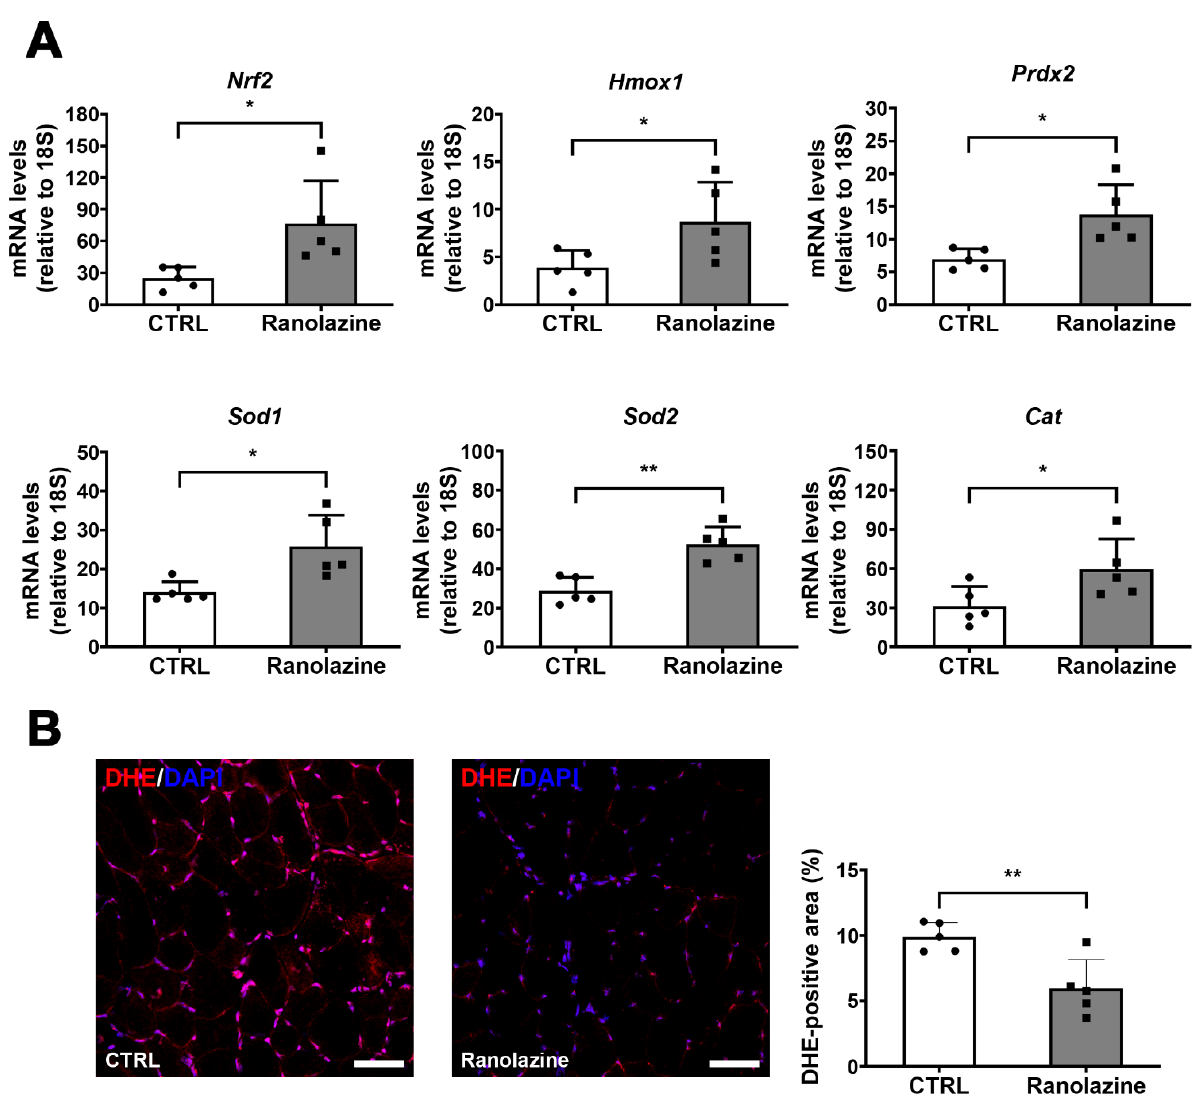
Figure 5. Up-regulation of antioxidant genes and decreased ROS in skeletal muscle upon Ranolazine treatment. ( A ) qPCR expression analysis of key genes involved in oxidative stress response on whole TA muscle lysates derived from old mice treated with Ranolazine or not (CTRL). Data are reported as relative to the housekeeping gene 18S. ( B ) Representative images of 8 µm-thick TA cryosections of old mice treated with Ranolazine or not (CTRL) stained with Dihydroethidium (DHE, red). Nuclei were counterstained with DAPI (blue). Scale bar = 50 µm. The histogram displayed the quantification of the percentage of DHE-positive area. Values are means ± SD. n = 5 for both experimental conditions. Unpaired t -test was used for comparison. ** = p < 0.01, * = p < 0.05.